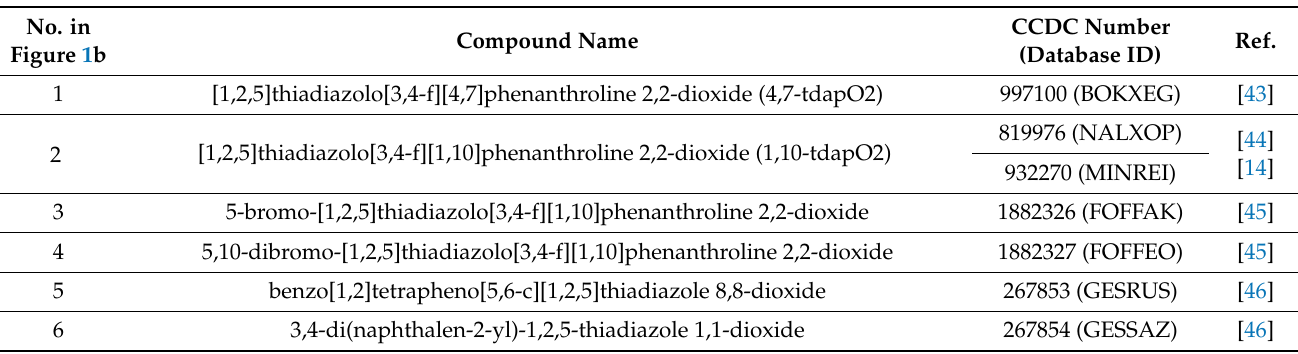
Table 1. All 1,2,5-thiadiazole 1,1-dioxides characterized structurally by means of the single crystal X-ray diffraction (according to the Cambridge Structural Database search using WebCSD tool: 10th June 2021). No. in Figure